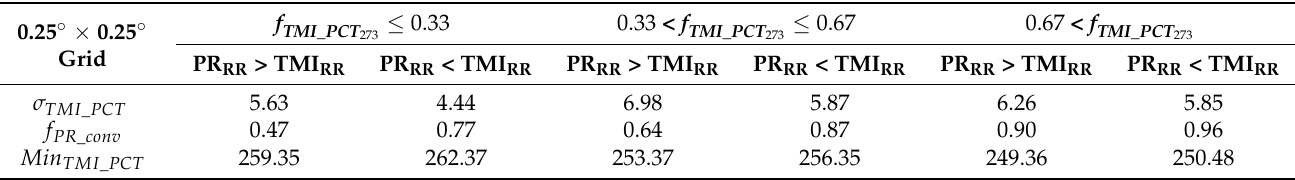
Table 1. Difference in the statistical characteristics of gridded TMI 85 GHz PCT standard deviation, PR convective fraction, and minimum TMI 85 GHz PCT for shallow precipitation system based on fraction of number of TMI 85 GHz PCT below 273 K threshold (Source: data processing).